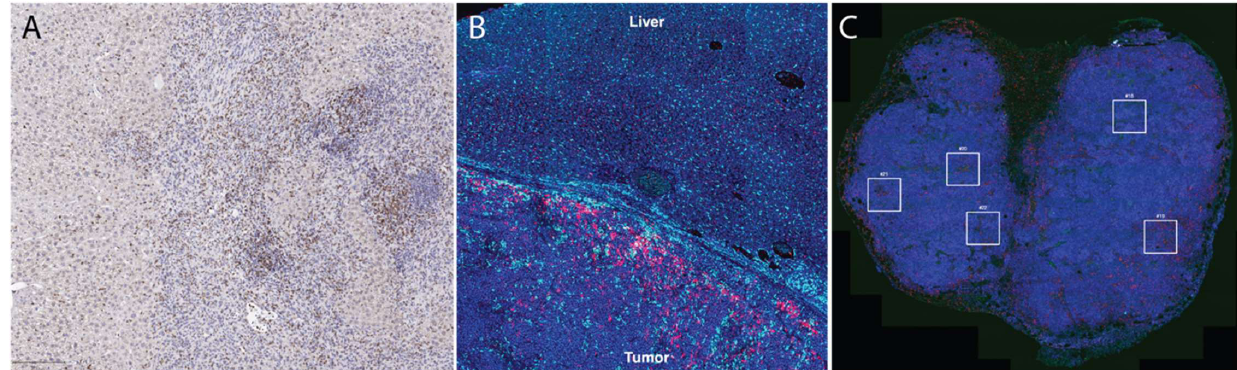
Figure 1. Tissue section-based immune profiling tools. ( A ), conventional immunohistochemistry of an orthotopic mouse liver tumor demonstrates infiltration of CD8+ cells (DAB, brown color stain) into the tumor. ( B ), immunofluorescence of CD68+ (light blue) and CD8+ (magenta) illustrates accumulation of macrophages and T cells at the liver-tumor border in a rat model of liver cancer. ( C ), Multi-color immunofluorescence (pan-cytokeratin = magenta, blue = DAPI, red = CD3, green = CD8) is helpful to characterize accumulation of multiple cell types; in this case, these images were used to